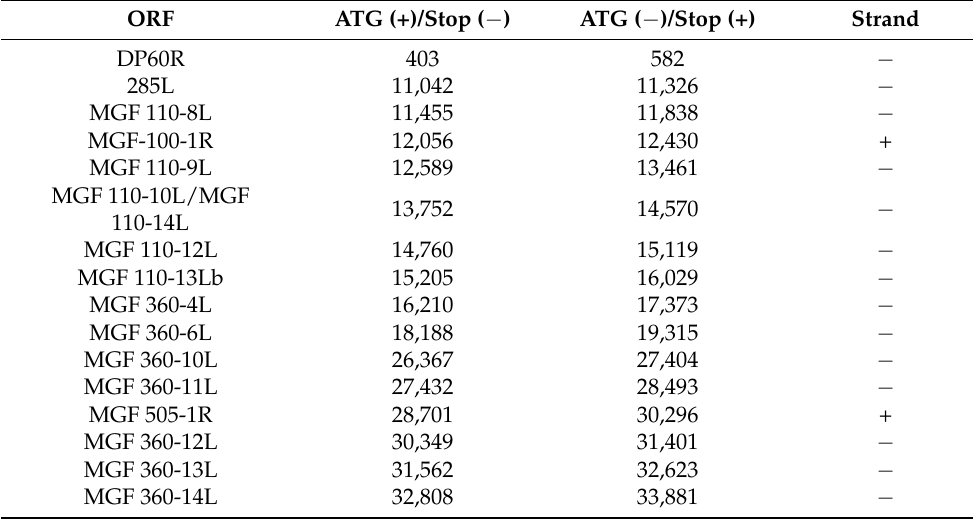
Table 1. List of genes lacking from the Ba71V genome. This table summarizes the lacking ORFs’ genomic